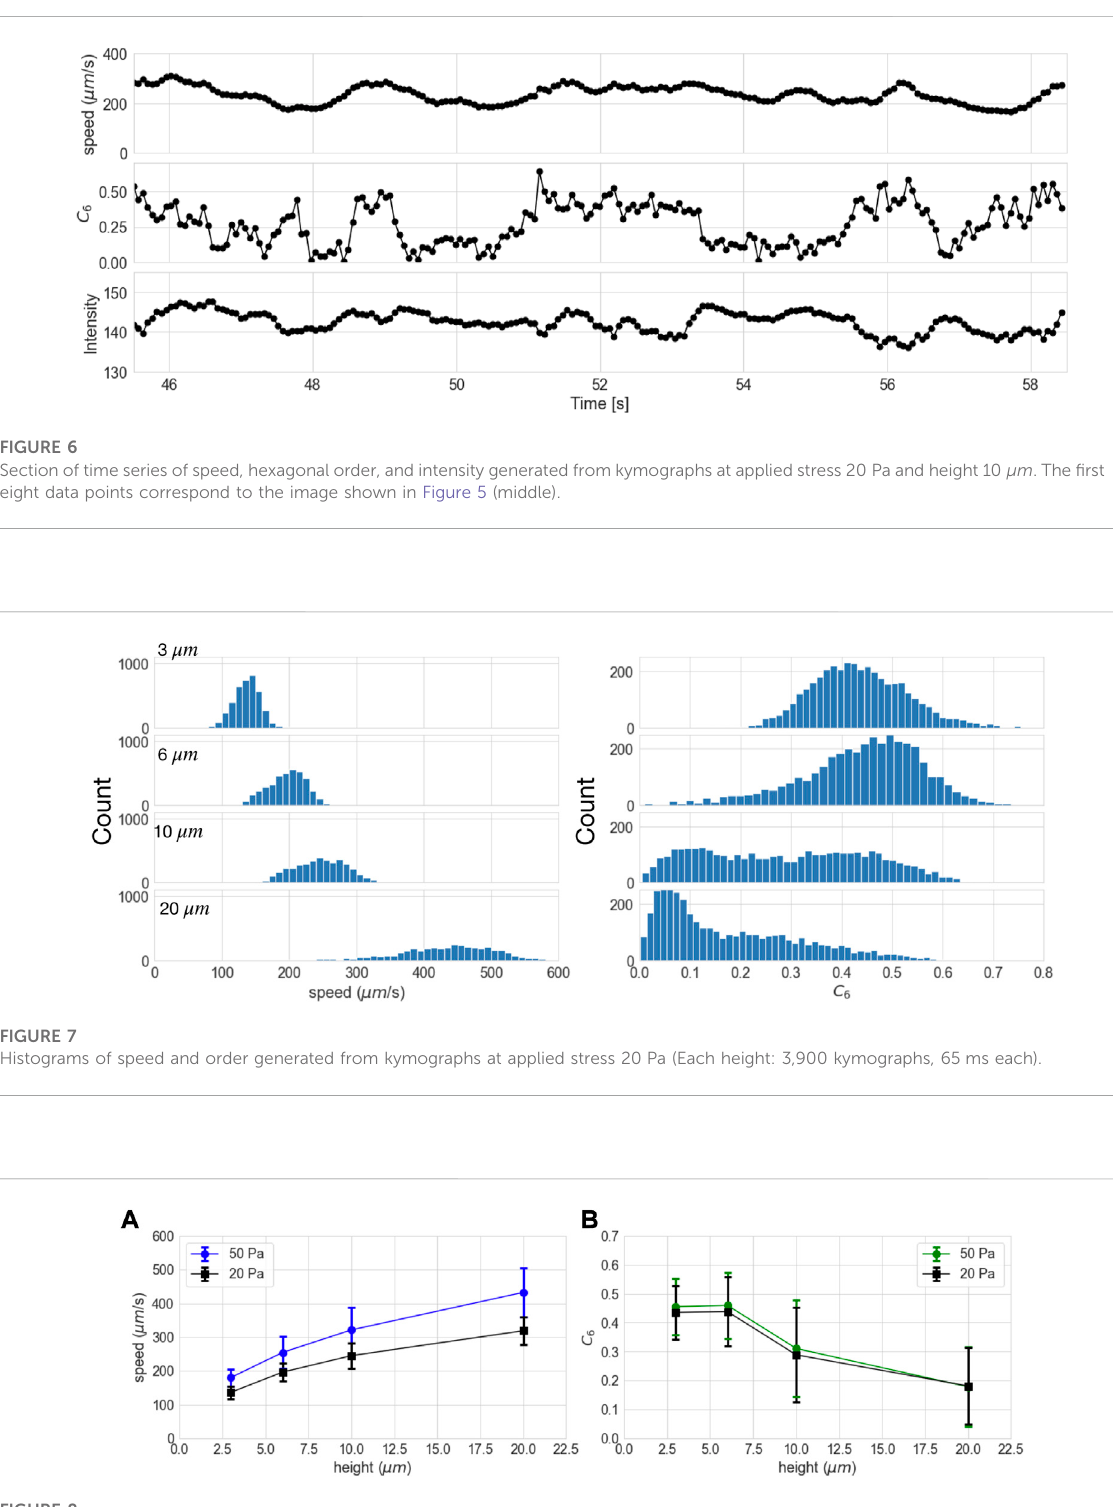
FIGURE 8 Pro fi les of average velocity (A) and order (B) for 20 and 50 Pa applied stress. Error bars are standard deviations (N =